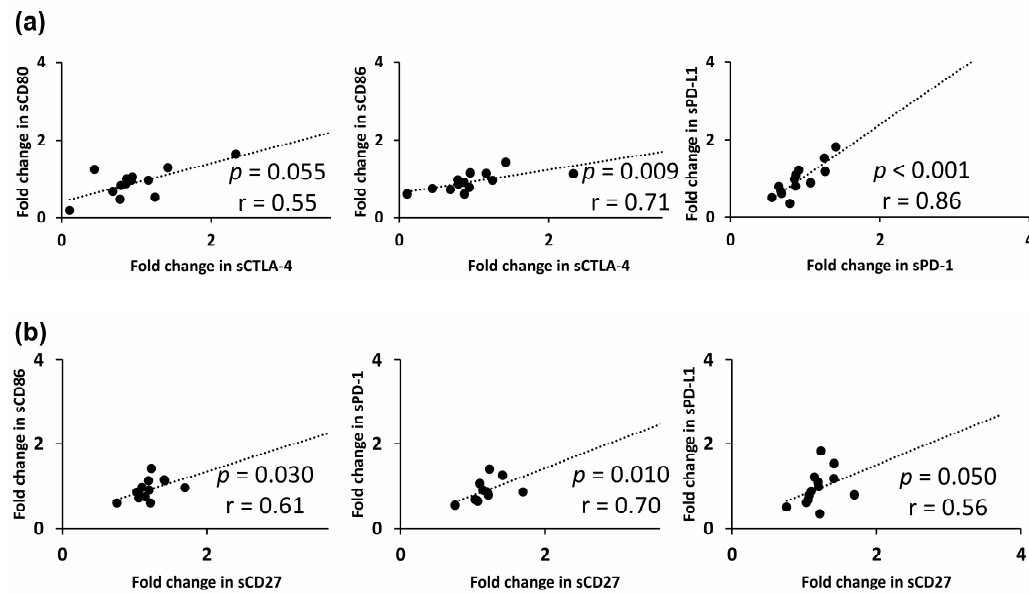
Figure A4. The relationships between fold-changes in soluble immune checkpoint protein levels in plasma at two to four weeks of lenvatinib treatment are seen. ( a ) A positive correlation was found between the fold-changes of soluble checkpoint receptors and their ligands, including sCTLA-4 with sCD80 / sCD86 and sPD-1 with sPD-L1, respectively. ( b ) The fold-change of sCD27 was positively correlated with those of sCD86, sPD-1, and sPD-L1. Spearman’s rank correlation test was used. A p -value of less than 0.05 was considered to be statistically significant.